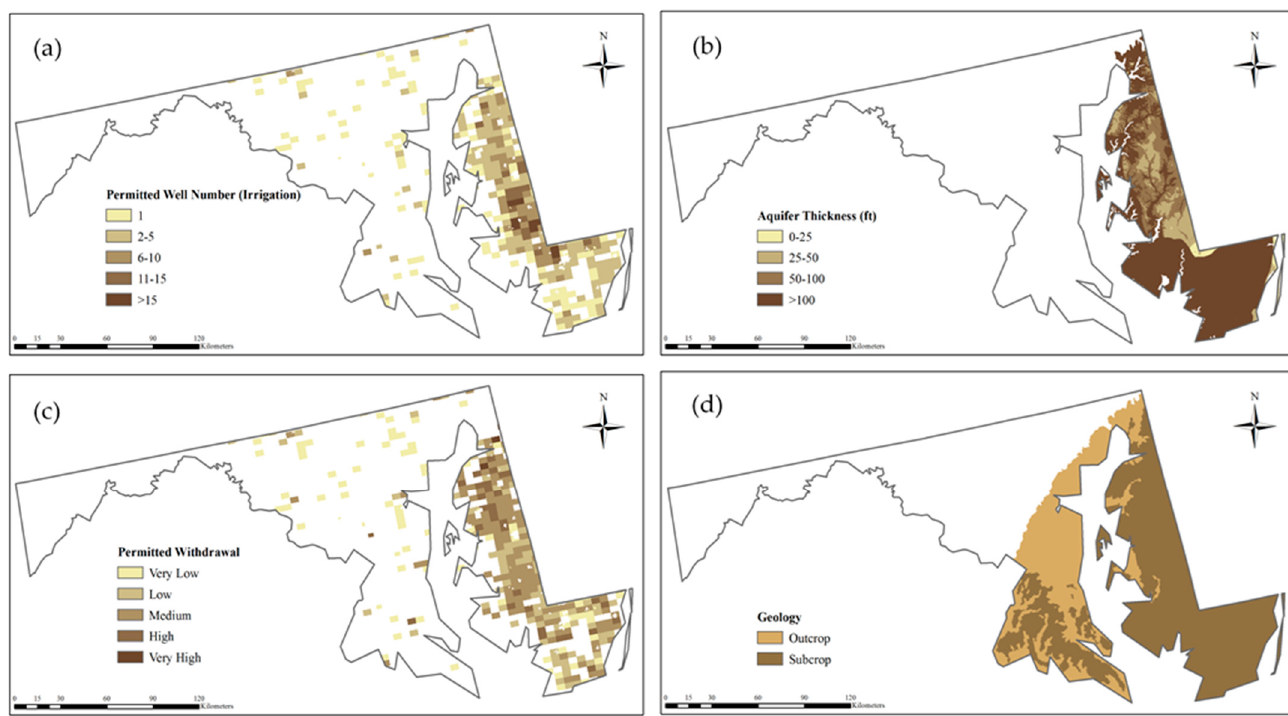
Figure A3. Reclassified maps that are generated to identify the groundwater vulnerability zones. ( a ) Permitted well density per tax map; ( b ) Spatial distribution of aquifer thickness; ( c ) Permitted water withdrawal rate per tax map; and ( d ) Spatial distribution of outcrop and subcrop areas.